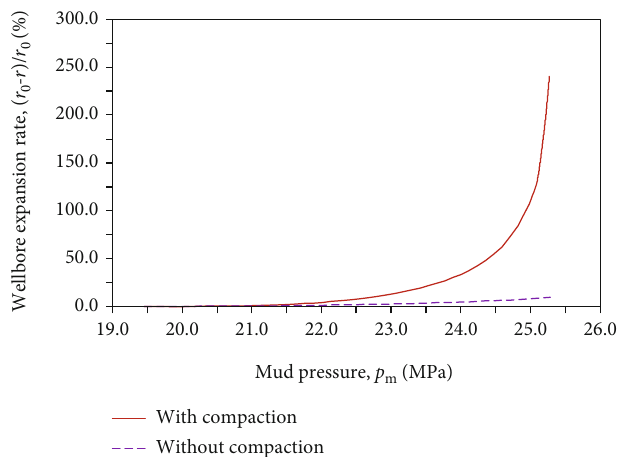
Þ / r 0 0 varying with the mud pressure